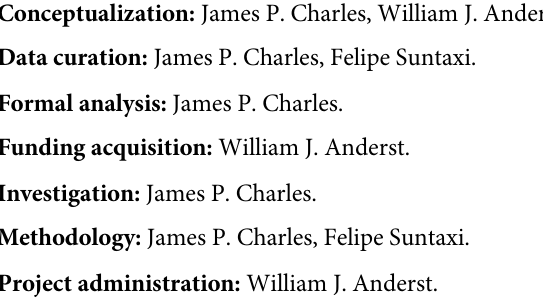
S11 Table. Linear regression results (R 2 values) to test the scaling relationships between muscle architecture parameters (L muscle fiber length; L :L —muscle length fiber length f- f m ratio; F estimated maximum isometric force; V muscle volume; L - muscle length) max- m- m and subject age, height, body mass, total limb mass and lower limb length. P values are shown in parentheses. Values italicized and in bold indicate statistical significance (p � 0.05). S12 Table. Mean differences (% differences) between lower limb muscle architecture data derived here from MRI, and those from a previous cadaveric study [3]. Muscle masses from our data were estimated from muscle volumes. L :L - Muscle fiber length muscle length ratio. f m PCSA- Physiological cross-sectional area. F - estimated maximum isometric force. Sarco- max mere lengths used to estimate optimal fiber lengths were sourced from Ward et al., [3]. S1 Fig. Mean L :L (fiber length muscle length ratio) for each muscle functional group, for f m subjects 1–10. For muscle functional group classifications, see Table 1. Horizontal dashed line represents the mean value from Ward et al., [3]. S2 Fig. Mean estimated maximum isometric force (F ; expressed as percent body weight) max values for each muscle functional group, for subjects 1–10. For muscle functional group classifications, see Table 1. Horizontal dashed line represents the mean value from Ward et al., [3]. (TIF) S1 File. Comparison to previous architecture